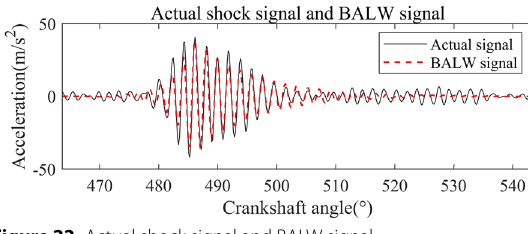
Figure 22 Actual shock signal and BALW signal